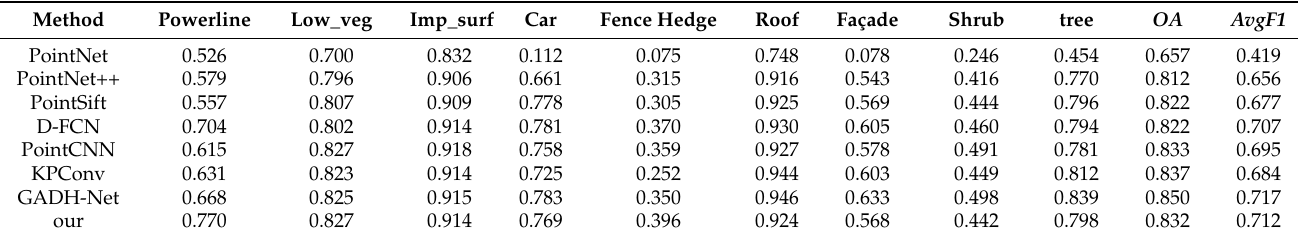
Table 7. Quantitative comparisons between our propose method and our point cloud-based models on the ISPRS benchmark dataset, all cells except the last two columns show the F 1